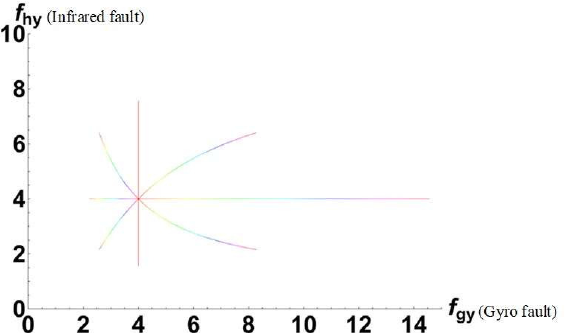
Figure 5. Representative geodesics of f 1 on the fault information